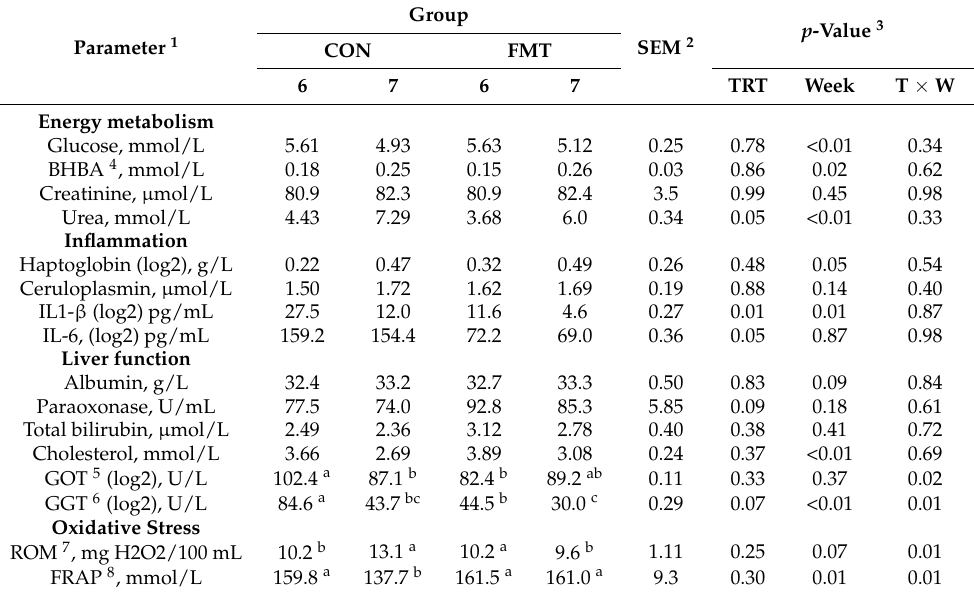
Table 4. Blood immunometabolic biomarkers during the weaning period (6- to 7-week old) in Holstein dairy calves raised under a conventional nutritional program (CON) or subjected to fecal microbiota transplantation (FMT).